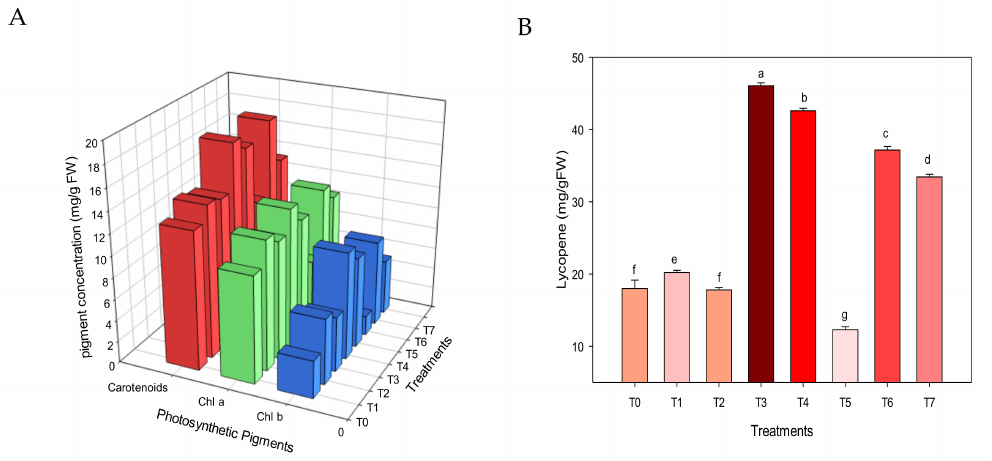
Figure 6. Effect of SWE on mitigating salt stress effects on fruit pigments ( A ) Photosynthetic pigments (Chlorophyll a, b and carotenoids—mg/g FW); ( B ) Lycopene (mg/g FW). Mean ( ± SEM) of 5 replicates. Within each time point, the same letter indicates no significant difference ( p ≤ 0.05) in a Tukey’s test. (T0—Control, T1—NC, T2—NC + S150 mM, T3—PC, T4—PC + S150 mM, T5—S150 mM, T6—SWE 80%, T7—T5 +